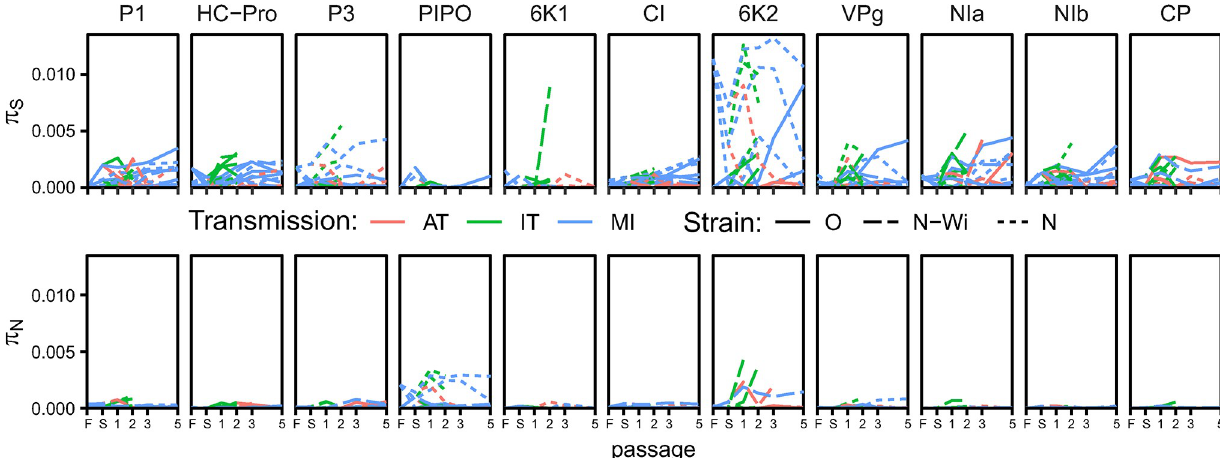
Fig 6. Temporal changes in nucleotide diversities for synonymous ( π populations in leaves) during experimental evolution using three different transmission modes. Lines connect PVY nucleotide diversities for separate lineages over the course of the experiment. Colors represent three different transmission modes; line types represent three different PVY strains used in the experiment. F–Founding, S–Source.